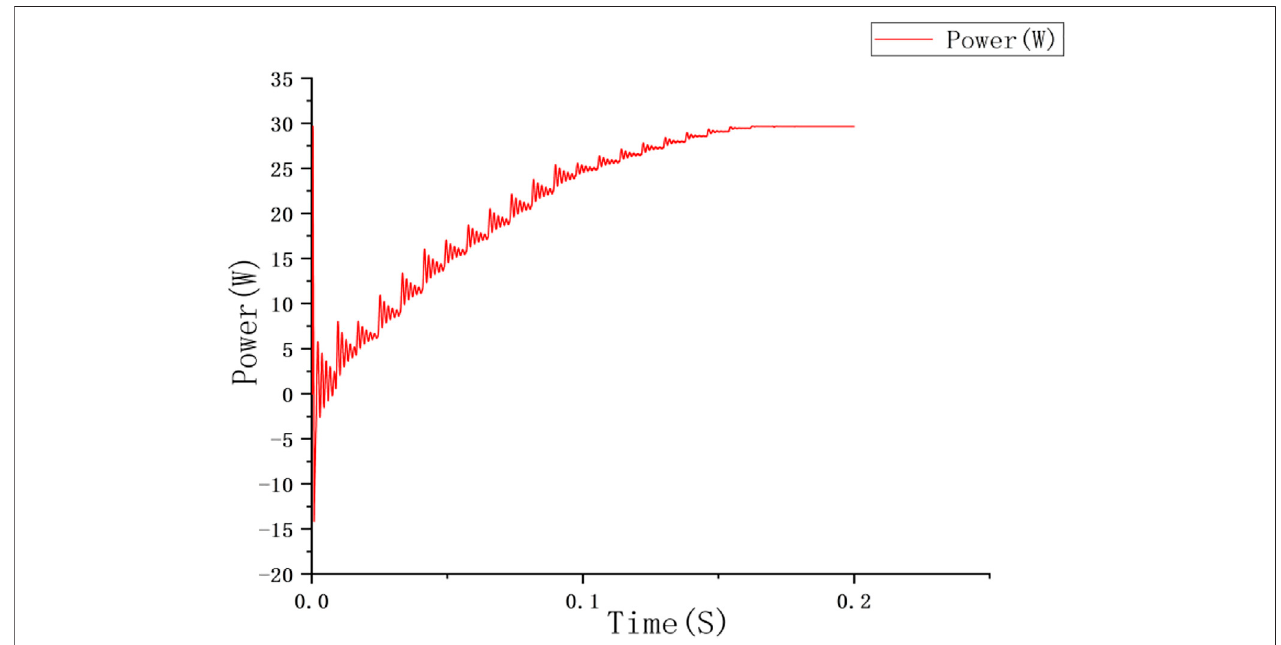
FIGURE 9 | Tracking time of MPP of soft switching.